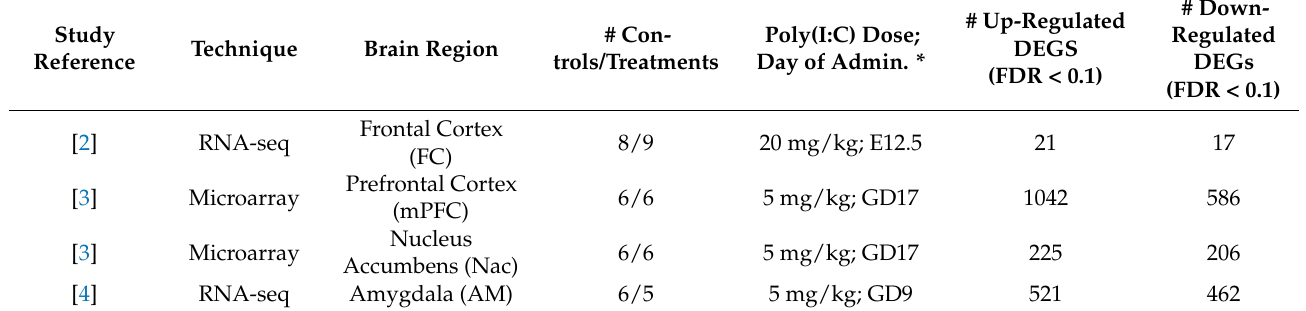
Table 1. Summary parameters of individual